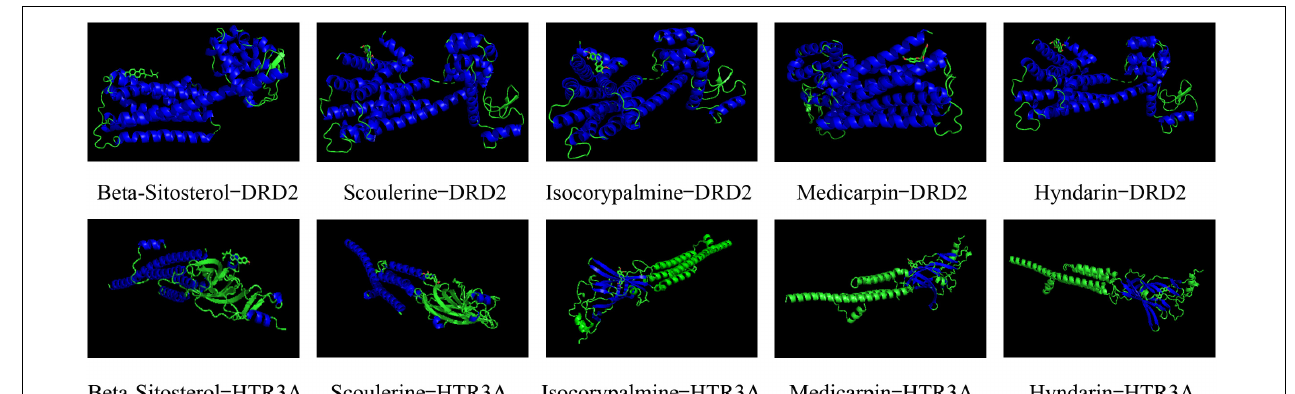
FIGURE 8 | Docking conformations of main active components with D(2) dopamine receptor (DRD2) and 5-hydroxytryptamine receptor 3A